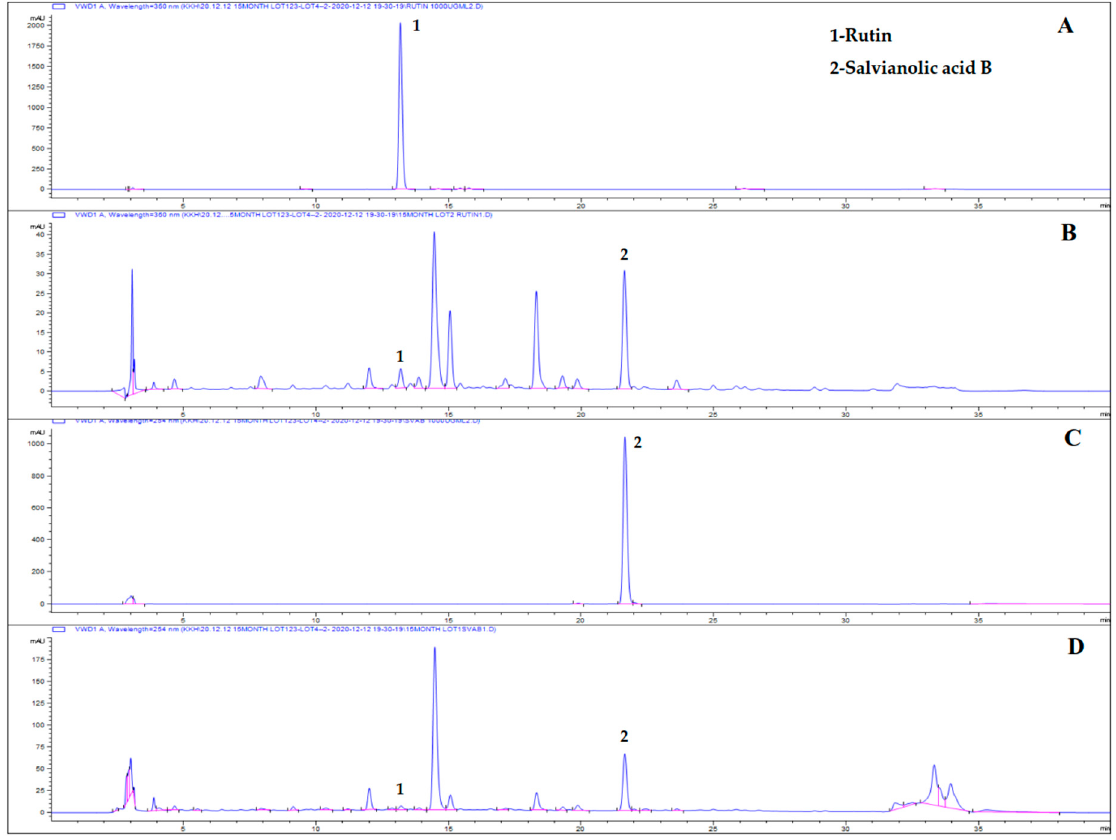
Figure 1. Representative HPLC chromatograms of rutin ( A ) at 360 nm, salvianolic acid B ( C ) at 254 nm, and ME of AP and SM at ( B ) 360 nm and ( D ) 254 nm.